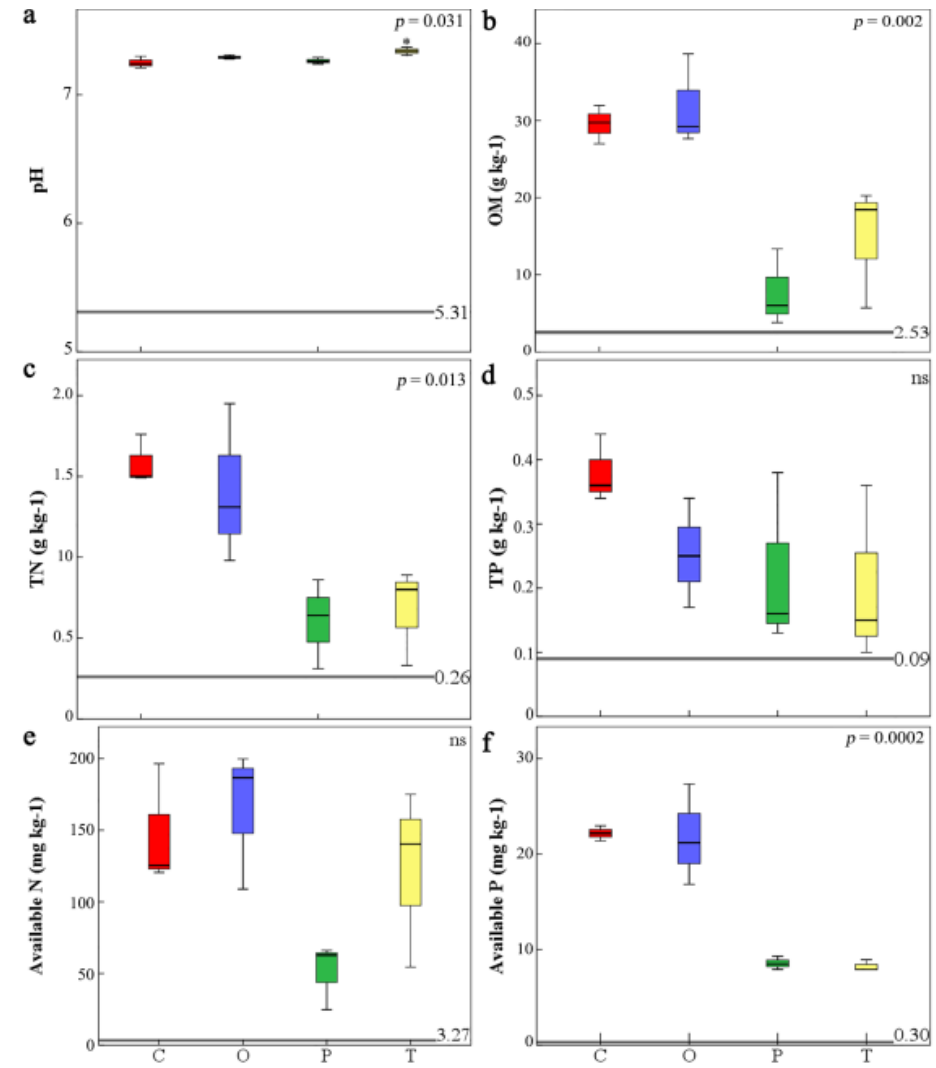
Figure 2. Soil characteristics in pH ( a ), OM ( b ), TN ( c ), TP ( d ), Available N ( e ), and available P ( f ) in four moss-dominated biocrusts and bare soil. The boxplots show the median (center black line) and interquartile ranges (box) of the individual effect sizes. p values denote significant differences among magnitudes or duration of manipulation based on Wilcoxon rank-sum test with Bonferroni correction. Horizontal grey solid lines and the number represent the background values of bare soil. OM: Organic matter, TN: Total nitrogen; TP: Total phosphorus; Available N: Available nitrogen, including the sum of ammonium nitrogen and nitrate nitrogen; Available P: Available phosphorus; C: Claopodium rugu- losifolium ; O: Orthotrichum courtoisii ; P: Polytrichum formosum ; T: Taxiphyllum giraldii ; ns: no signifi- cant differences.